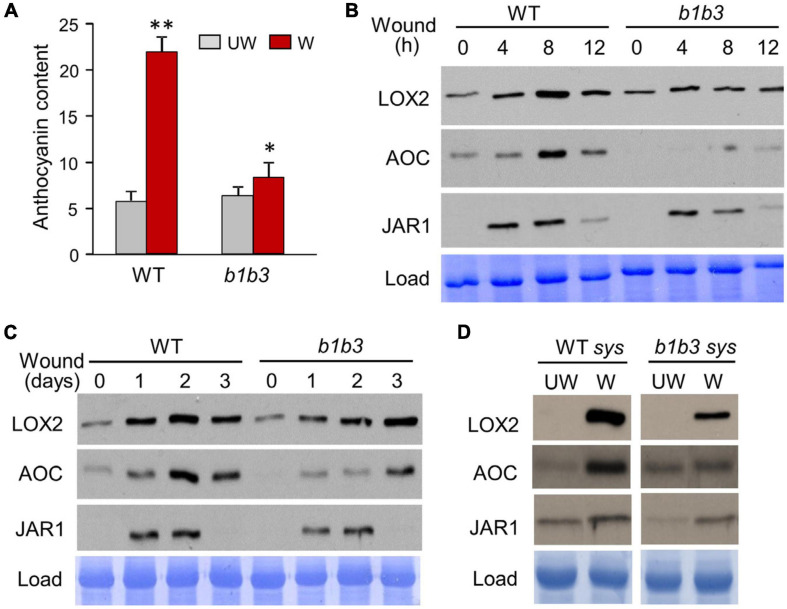
Wound-inducible proteins accumulate to a lesser extent in b1b3. (A) Anthocyanin levels in wounded (W) and unwounded (UW) WT and b1b3 plants. Plants were wounded multiple times following the WIGI (wound-induced growth inhibition) wounding scheme described in the section “Materials and Methods.” Bar graphs represent means ± SD (n = 5). Asterisks denote statistical significance by Student t test compared to UW WT: ∗P < 0.05, ∗∗P < 0.01. (B) Immunoblots showing a 12-h wounding time course of LOX2, AOC, and JAR1 in WT and b1b3. Fully expanded rosette leaves of 25-day-old plants were crushed two times across the midrib per leaf with a hemostat. (C) A 3-day wound time course showing lower protein accumulation for b1b3. Two leaves per plant were wounded once every day for 3 days and samples collected 12 h after wounding each day. (D) Protein accumulation in the undamaged systemic leaves of unwounded (UW) and wounded (W) WT and b1b3 plants. Plants were wounded according to the WIGI wounding scheme as in (A). Remaining undamaged leaves were harvested 1 day after final wounding and used as systemic samples.